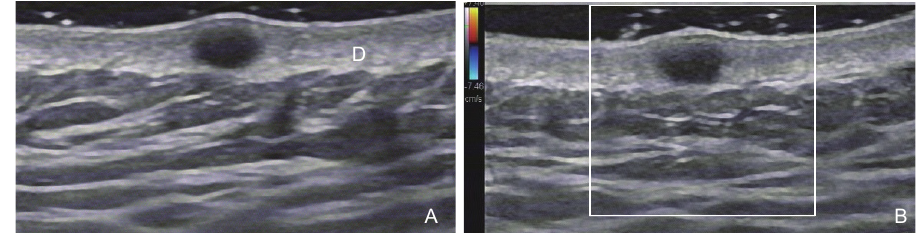
Figure 1 A dermatofibroma in the dermis. (A) Grayscale sonography showed a 5×3mm well-circumscribed hypoechoic lesion located at dermis (D); (B)